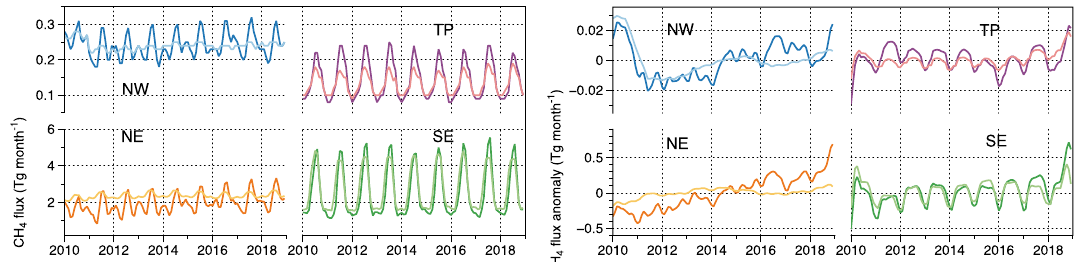
Figure 2. CH 4 flux interannual variability and 2010–2018 anomaly in four regions NE, SE, NW, and TP in China, lighter colour standing for prior emission and darker colour standing for posterior emission in each